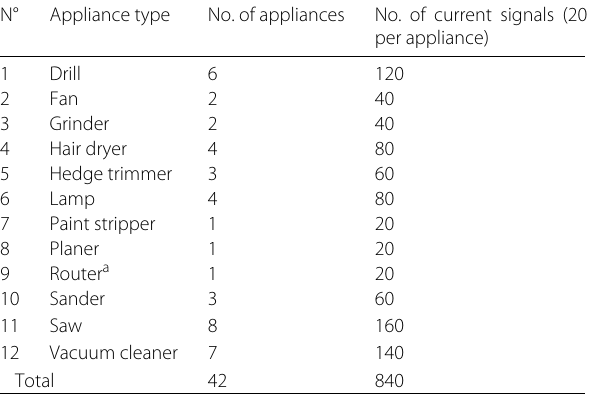
Table 1 COOLL dataset summary